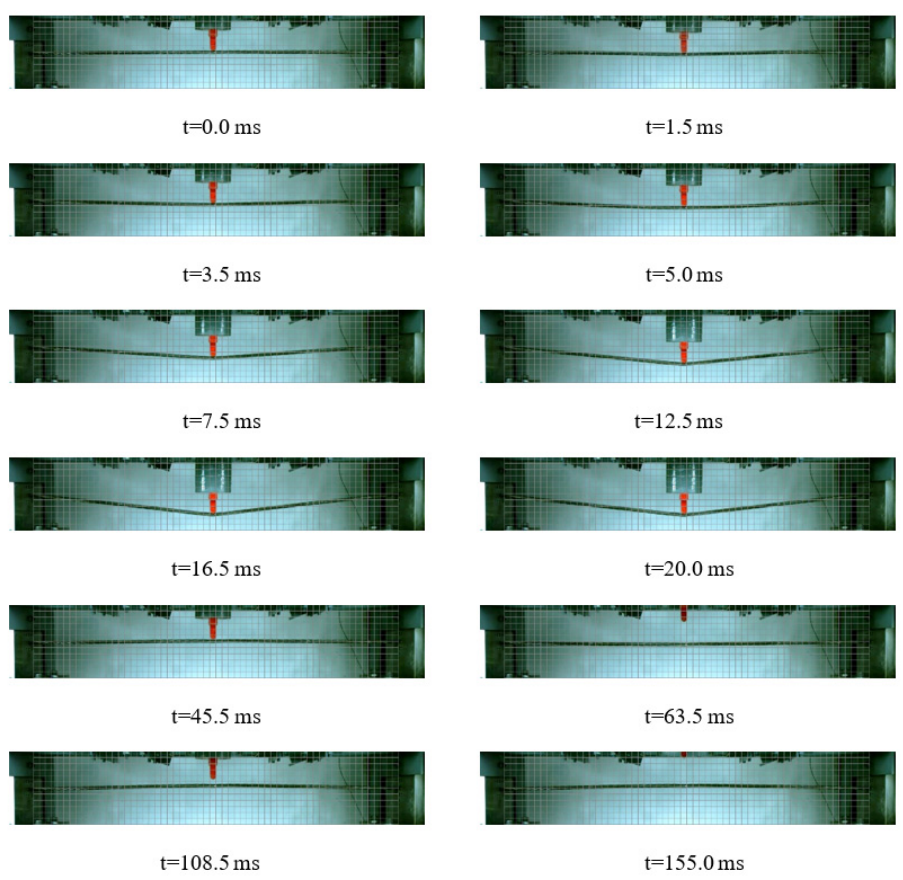
Figure 6. High − speed photographs of strand collisions for the working cases of µ p = 0.288 and V 0 = 7.08 m/s.